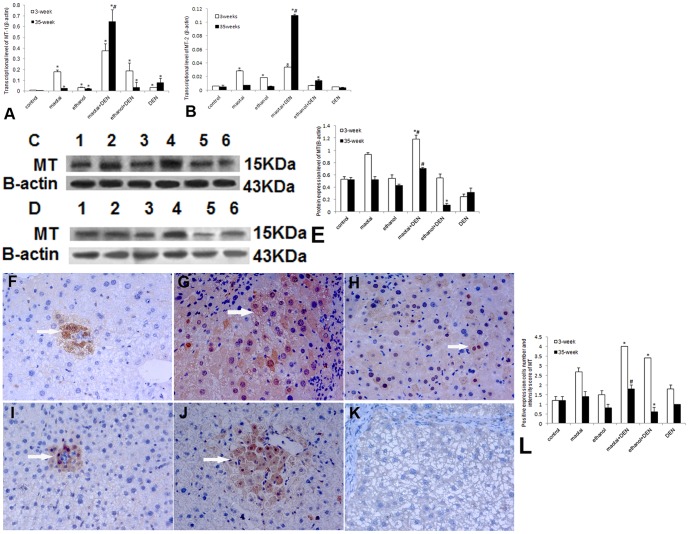
The expression level of MTs in mice liver at 3-week and 35-week.A-B: Real-time RT-PCR analysis of MT-1/2 gene expression. Both the Maotai +DEN group and ethanol+ DEN group produced a significant induction of MT-1 in mRNA level at 3-week. But Maotai +DEN group still produced a dramatic induction of MT-1/MT-2 at 35-week, it was about 19 times of ethanol+ DEN group in MT-1 (p<0.01). C–D: Western blot analysis of MTs protein level at 3-week and 35-week. lane 1.Control; lane 2.Maotai; lane 3.Ethanol; lane 4.Maotai+DEN; lane 5.Ethanol+DEN; lane 6.DEN; E: Quantification of MTs level by western blot analysis. The specific up-regulation of MT-1/2 was confirmed through western blotting assay. Maotai+ DEN always had a higher MTs protein level. but it was generally lower in ethanol+ DEN group. F-H, I-K: Light microscopy of MTs expression through Immunohistochemistry in control group, Maotai+ DEN group and ethanol+ DEN group at 3-week and 35-week (400× magnification, allows indicate MTs expression cytolymph and nucleus positive cells); L: Quantification of MTs expression in Immunohistochemistry. Immunohistochemical assay also showed similar MTs protein expression with western blotting assay (p<0.01). *Significantly different in Maotai+ DEN group and ethanol+ DEN group from control group, #Significantly different in Maotai+ DEN group from ethanol+ DEN group, p<0.05.